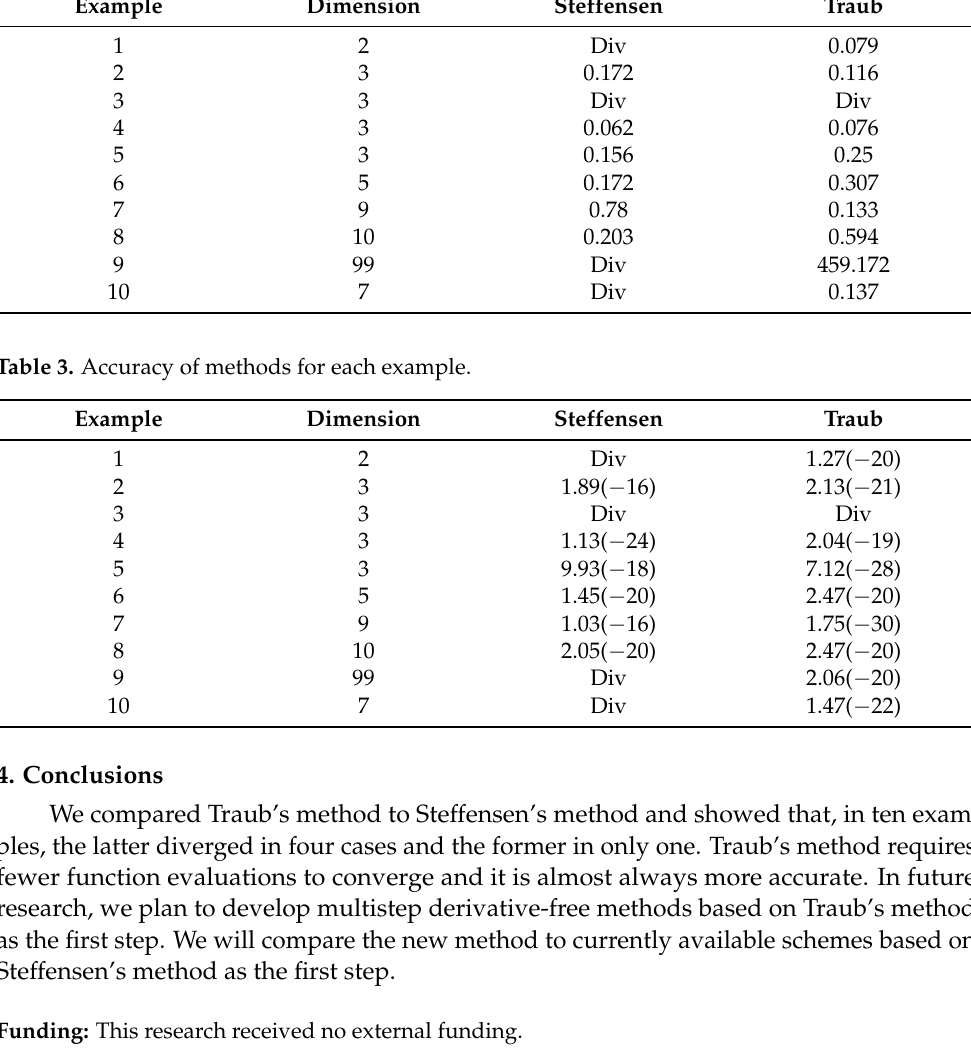
Table 2. CPU time (in seconds) used by each method for each example. Example